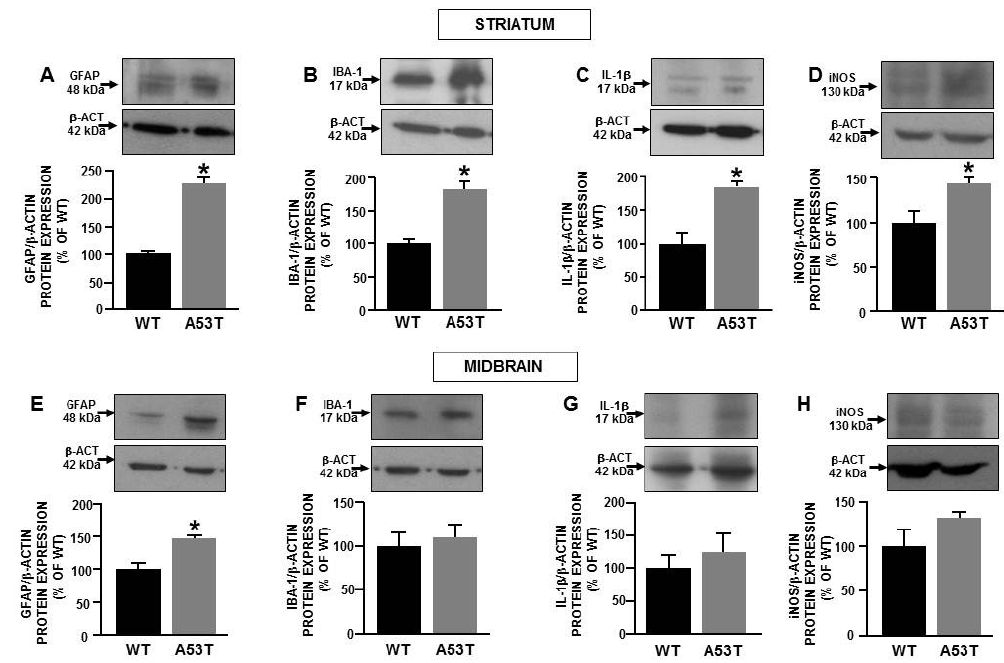
Figure 4. Activation of neuronflammation in 16-month-old A53T- α -syn mice. Western blot analysis of GFAP, IBA-1, iNOS, and IL-1 β protein expression in striatum ( A – D ) and midbrain ( E – H ) from A53T- α -syn and WT mice. Each bar represents the mean ± S.E.M. of the percentage of different experimental values obtained in three independent experimental sessions. * p < 0.05 compared to WT mice.